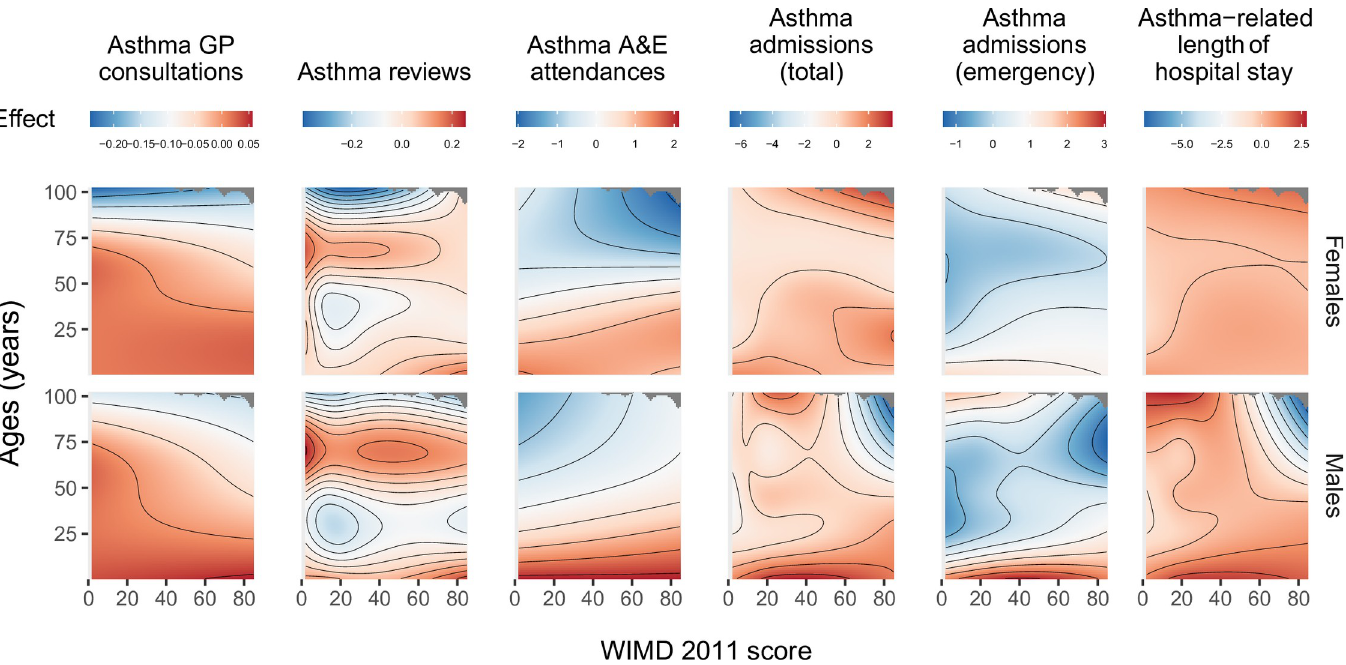
Fig 5. Full tensor product smooths from GAMs of asthma-related health service utilisation showing interaction between the WIMD 2011 score and age in males and females. The colour represents the partial effect (blue = lower, red = higher). The models did not include separate smooths for the WIMD 2011 score and age. A&E, accident and emergency; CI, confidence interval; GAM, generalised additive model; GP, general practitioner; WIMD, Welsh Index of Multiple Deprivation.